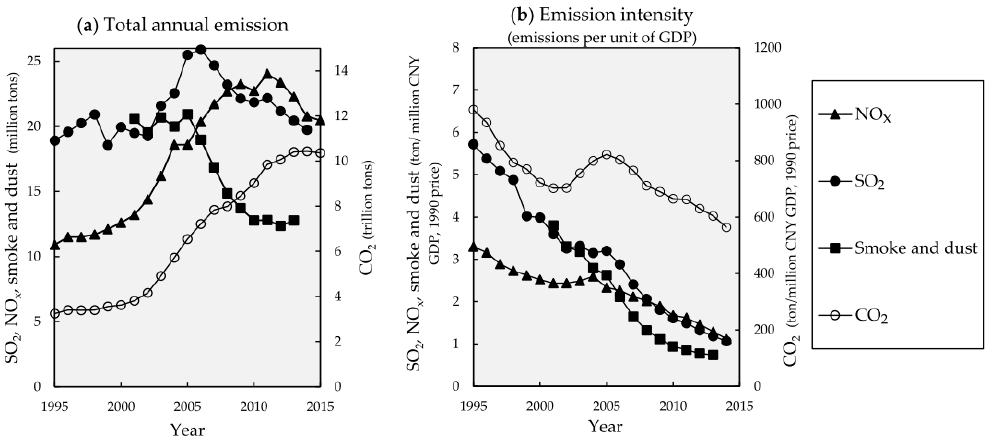
Figure 1. ( a ) Total annual emission; ( b ) Emission intensity of major pollutants and CO 2 in China, 1995–2014. Data on emissions of SO 2 , smoke and dust, and total suspended particulates (TSP) from National Bureau of Statistics of China (CNBS) [22]; data on CO 2 emission from global carbon atlases [23–25]; emission intensity data is calculated based on the 1990 price in CNY.